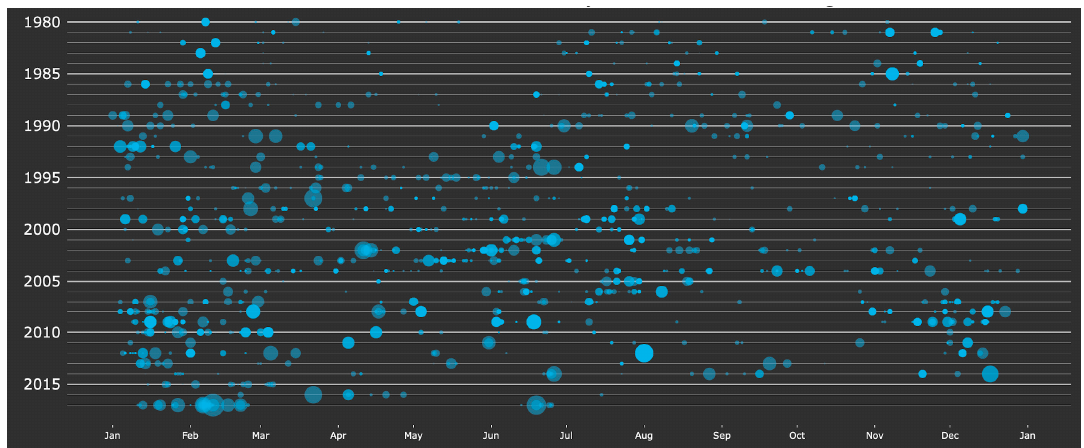
Figure 7. Prescribed fire history in Everglades National Park and Big Cypress National Preserve, 1980 to 2017. The size of each point corresponds to the size of the fire.